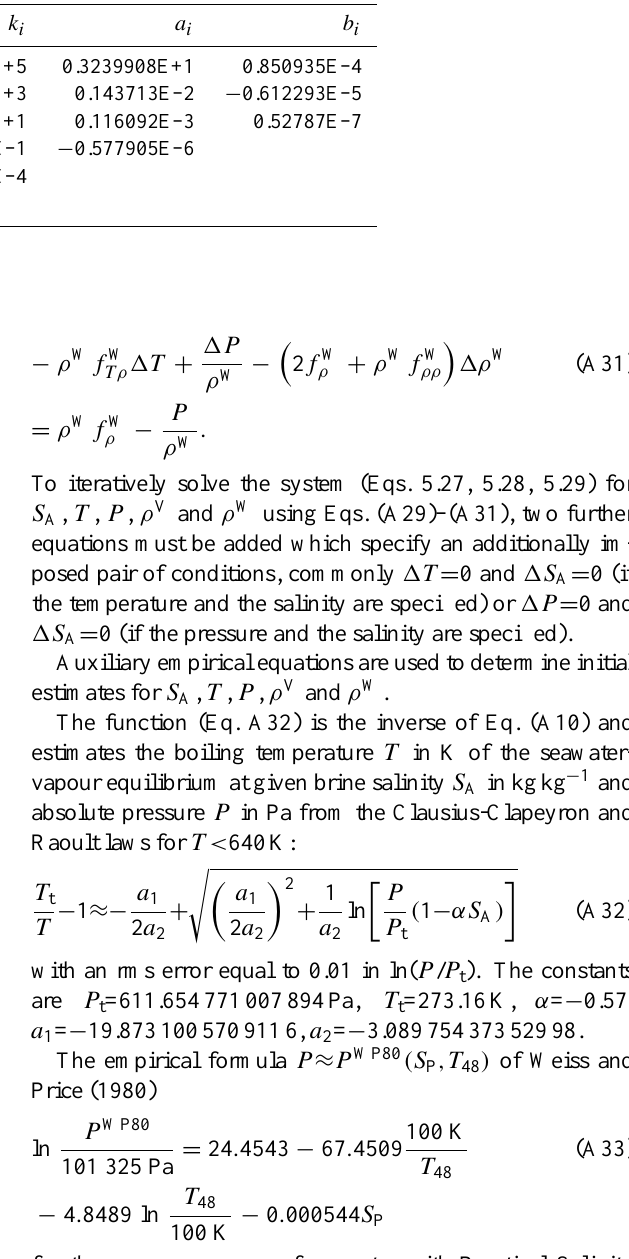
Table A2. Coefficients of Eq.